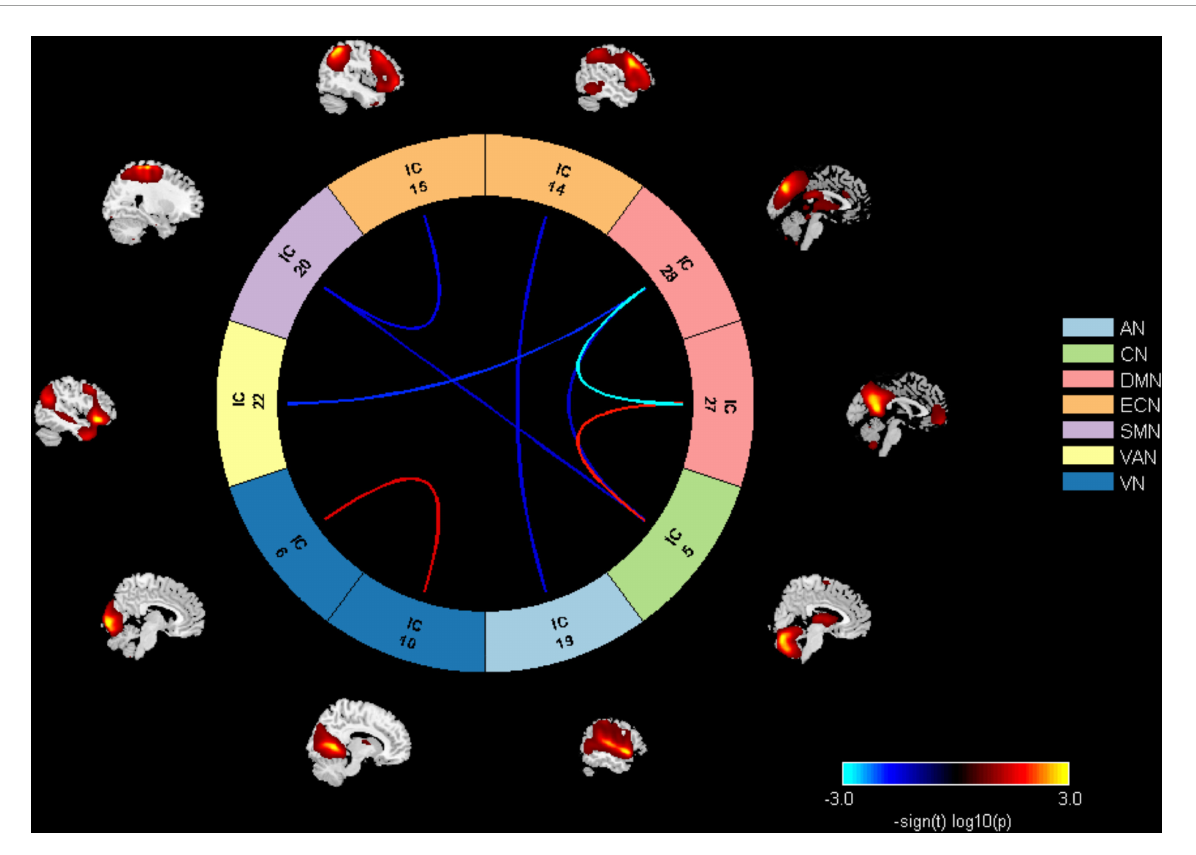
FIGURE3 Inter-network connectivity differences between groups. AN, auditory network; CN, cerebellum network; DMN, default mode network; ECN, executive control network; SMN, sensorimotor network; VAN, ventral attention network; VN, visual network.